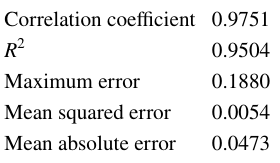
Table 13 Correlation coefficient, R 2 , maximum error, mean squared error and mean absolute error of correlation